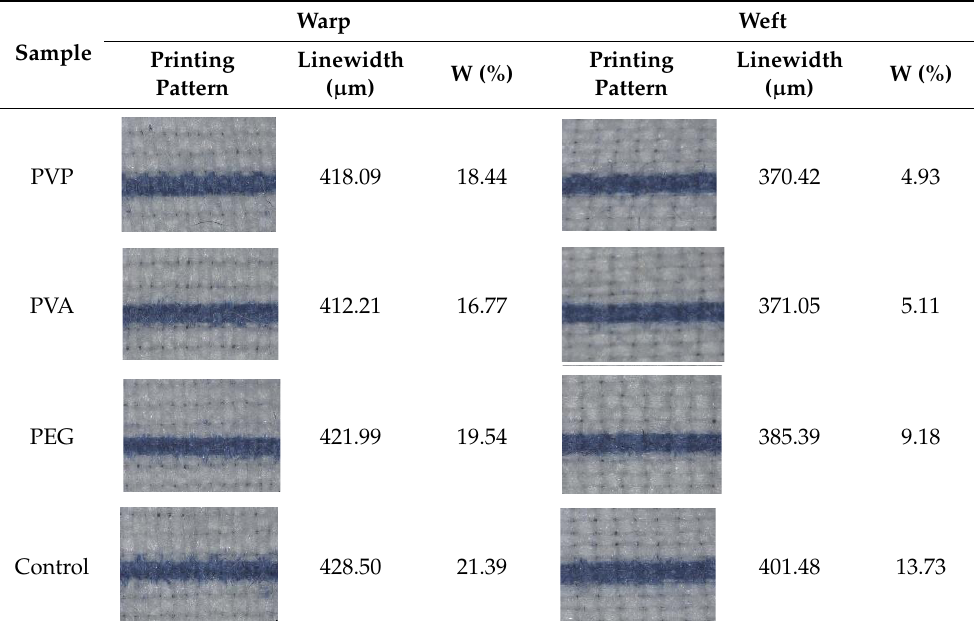
Table 5. Linewidth and linewidth relative change (W) of printed fabric. Sample Sample